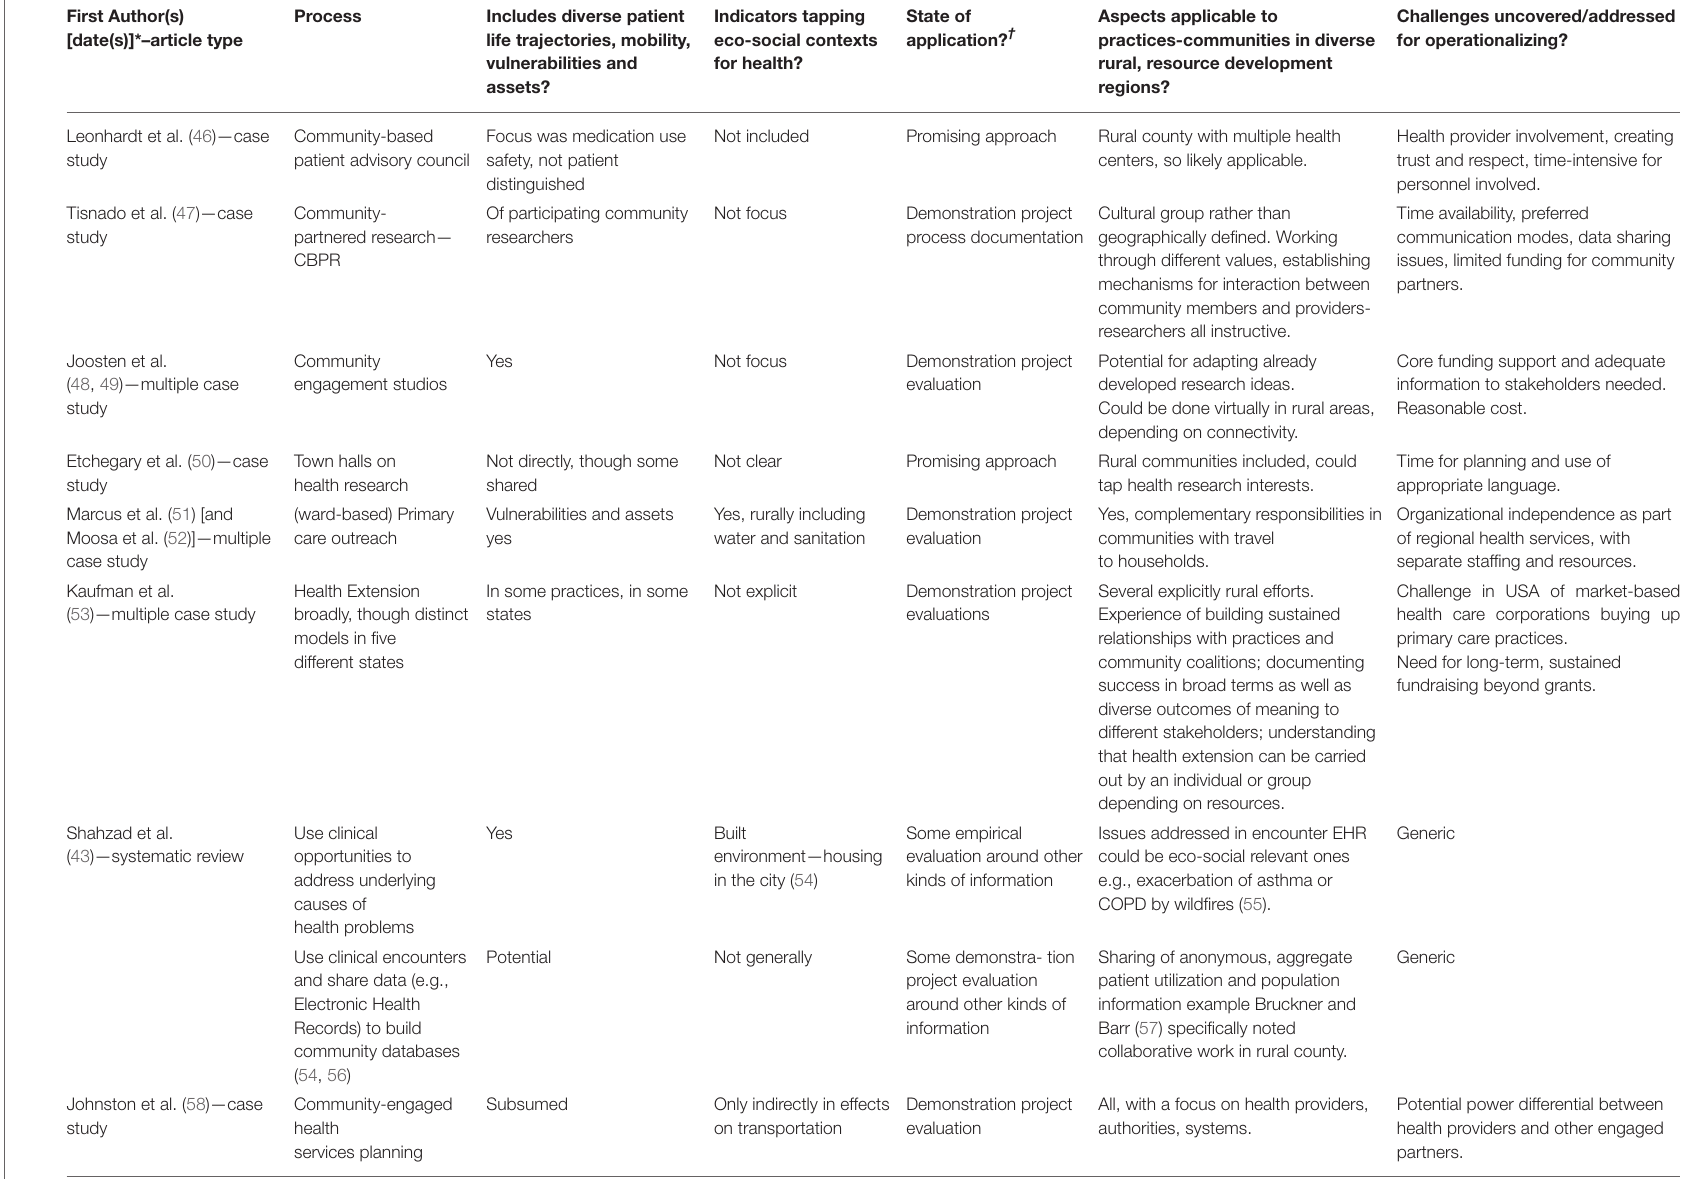
TABLE 2 | Assessment of potentially most relevant processes in relation to reflective